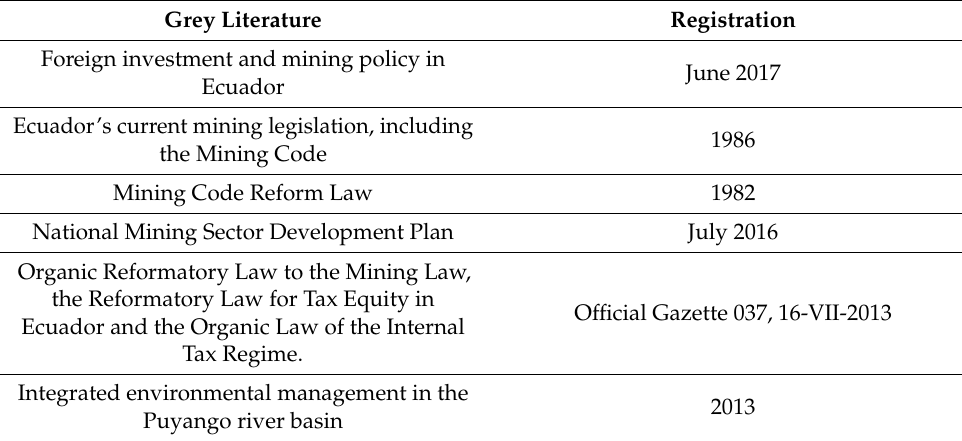
Table 3. Grey literature methodological